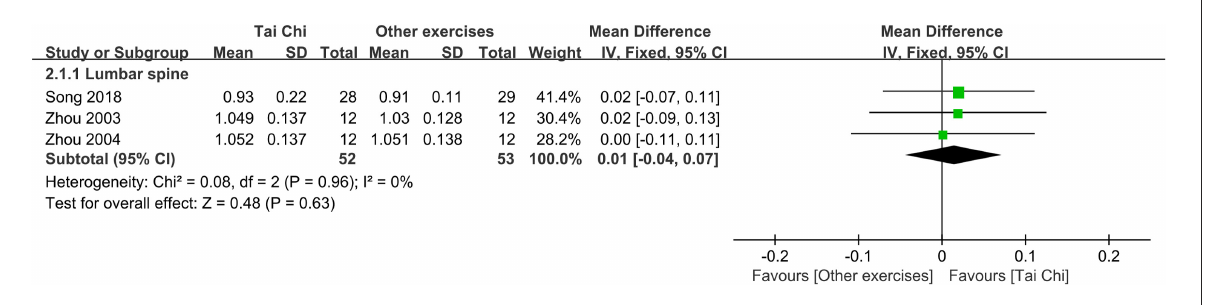
FIGURE4 Forest plot of meta-analysis results for Tai Chi vs. other exercises.